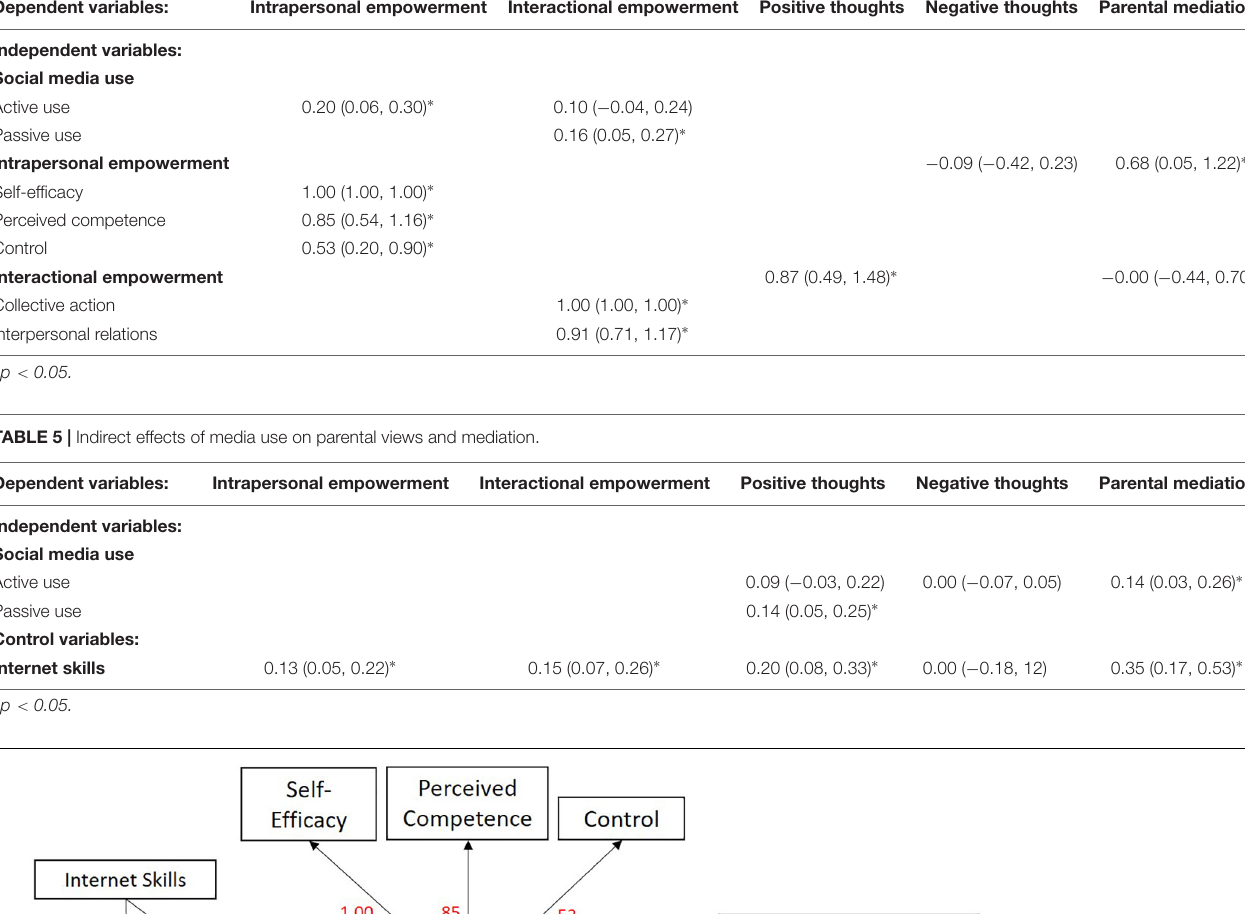
TABLE 4 | Direct effects of independent variables on dependent variables.